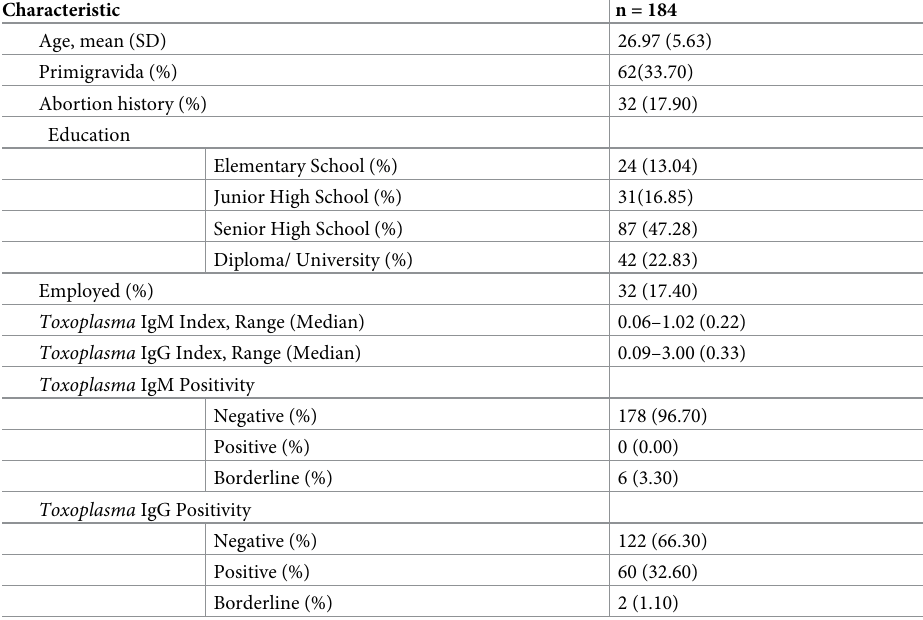
Table 1. Characteristics of pregnant mother attending primary health centre (Puskesmas) for antenatal care in Makassar,